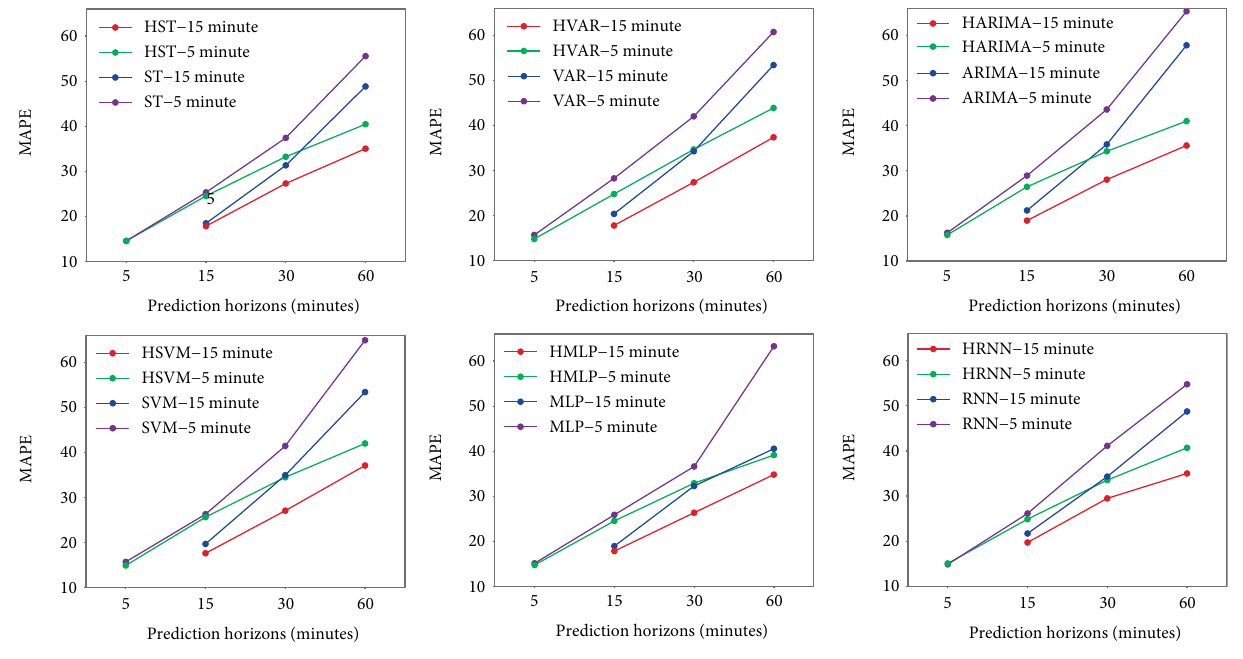
Figure 7: The MAPE values of models for different horizons and aggregation levels in peak hours on station